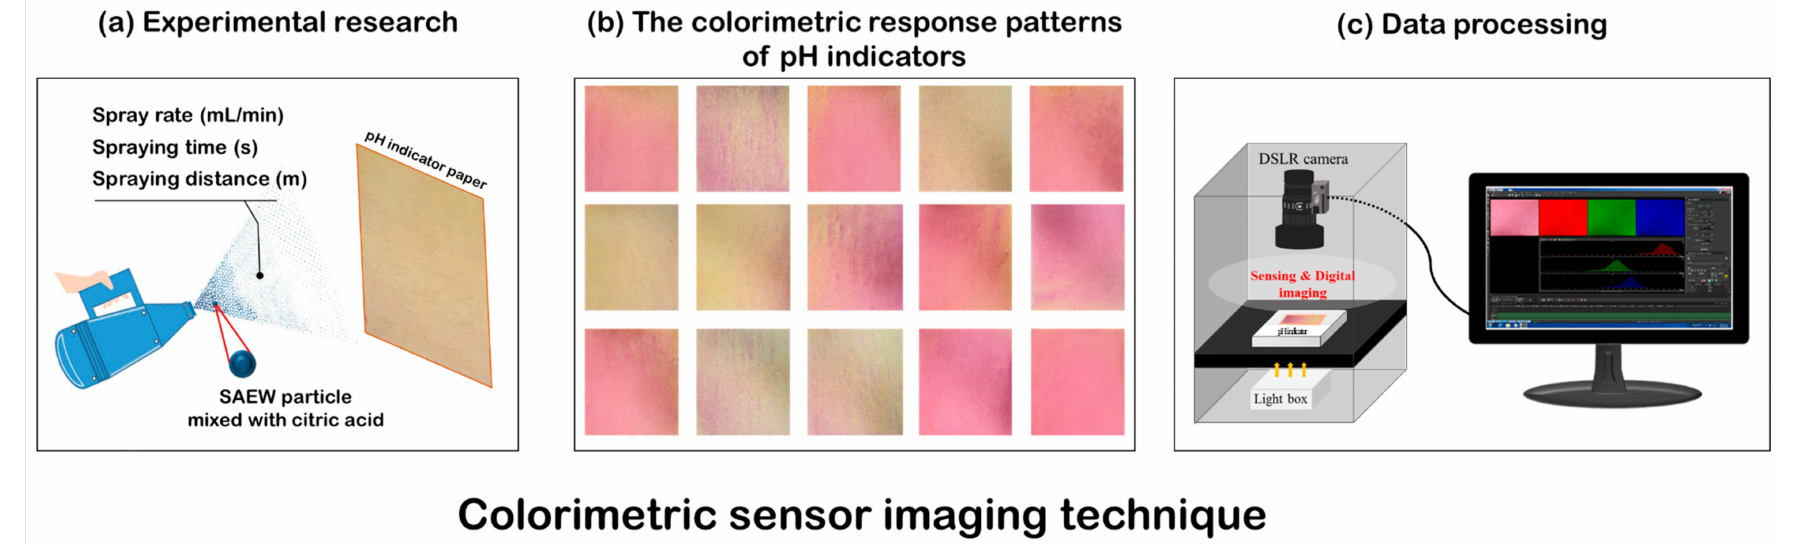
Figure 1. Schematic of the experimental design for optimized spraying conditions. Measurement of ( a ) dispersion and contact pattern of SAEW spray droplets, ( b ) colorimetric response patterns of pH indicators, and ( c ) SAEW spray droplets via a computational